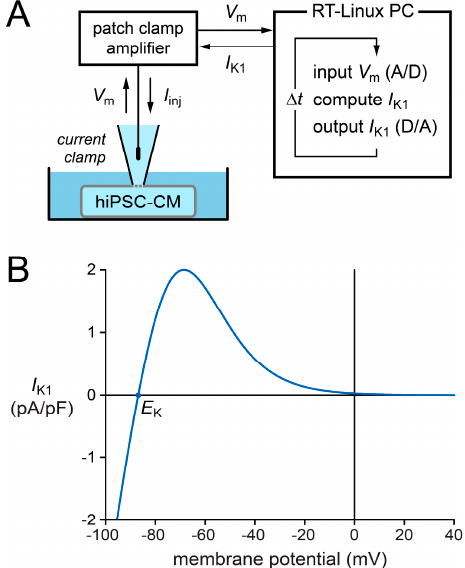
Figure 2. Experimental approach to supply a patched hiPSC-CM with a synthetic inward rectifier potassium current ( I K1 ). ( A ) Diagram of the experimental setup. The Real-Time